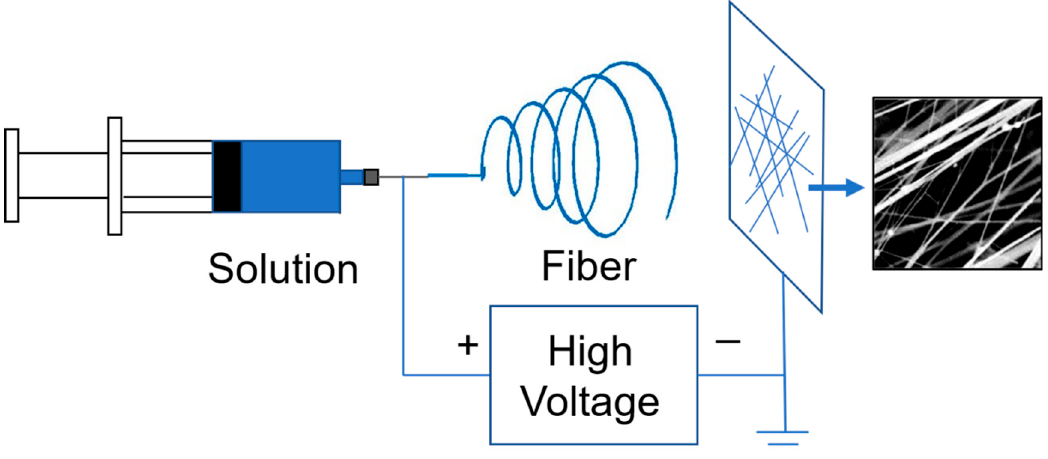
Figure 2. The device diagram of the electrostatic spinning process.